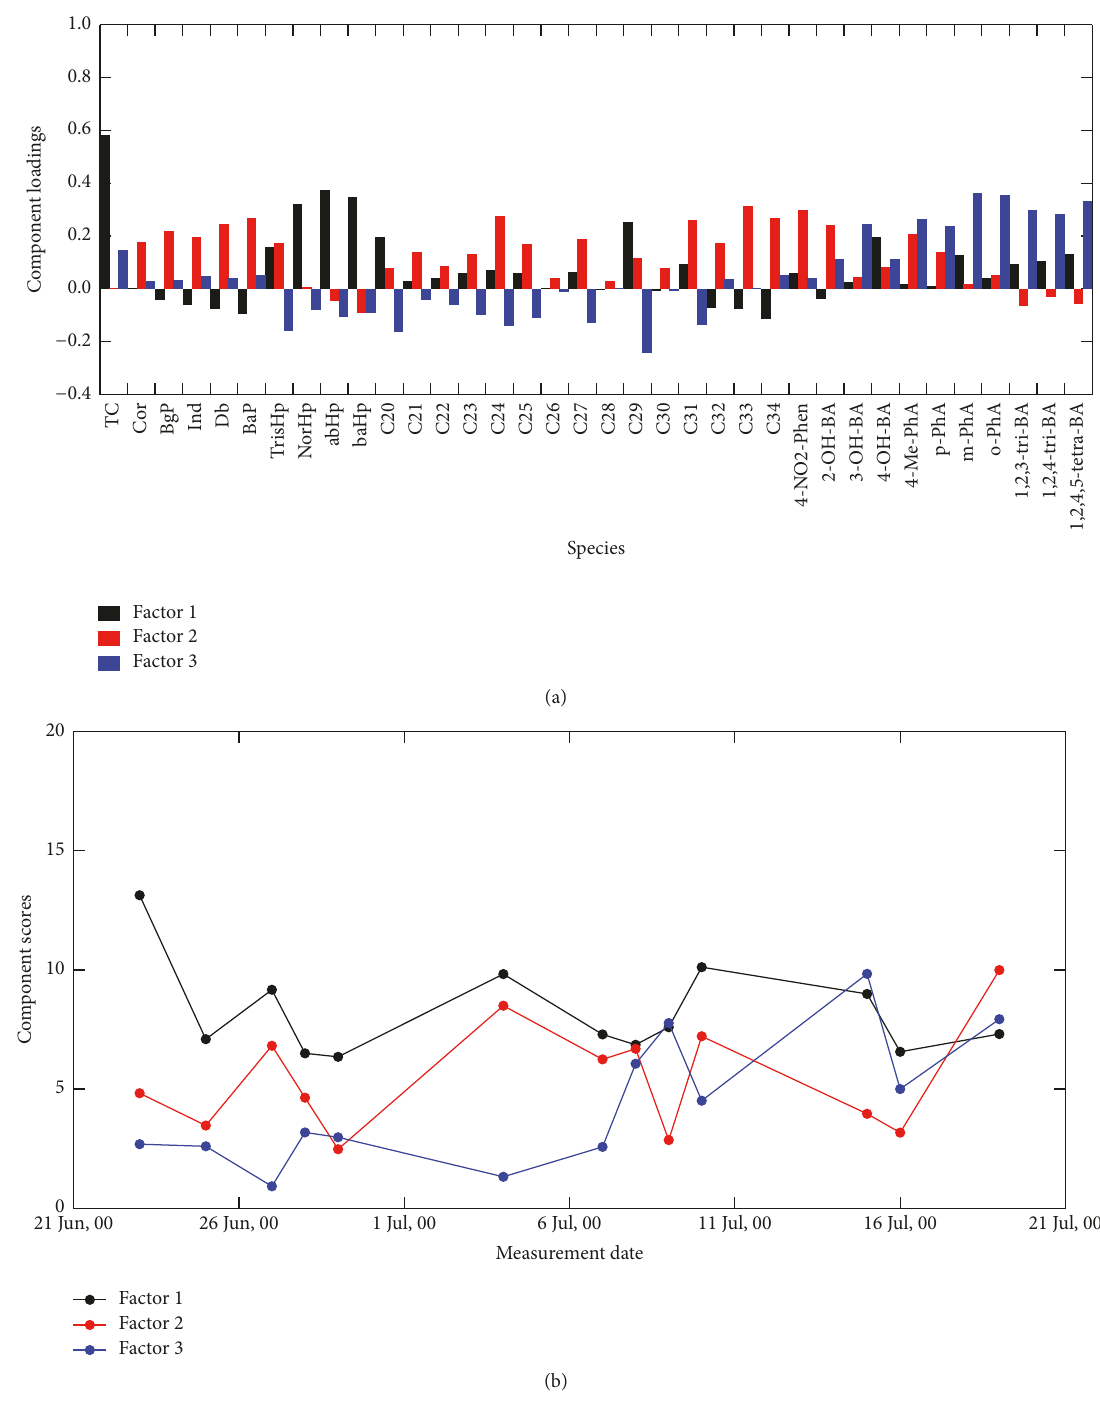
Figure 10: (a) Loading of three factorial analyses and (b) time series score of three loadings for the Simcoe dataset.